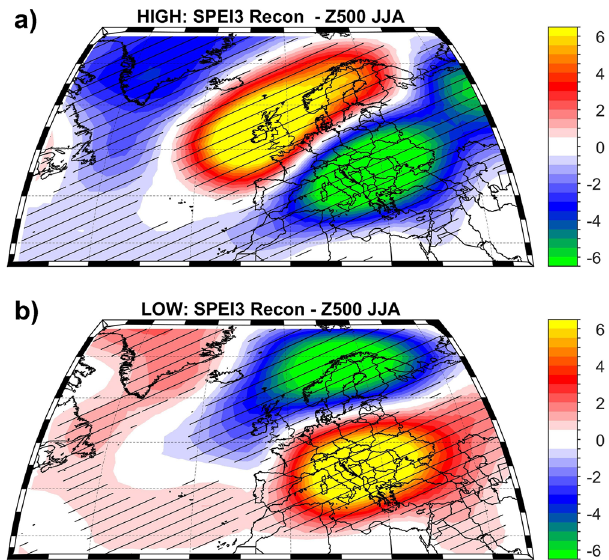
Fig. 5 Large-scale atmospheric circulation. a The composite map between High SPEI3 (< − 1 std. dev.) and summer (JJA) Geopotential Height at 500 mb (Z500) 100 and b the composite map between Low SPEI3 (>1 std. dev.) and summer (JJA) Geopotential Height at 500 mb (Z500). The hatching highlights signi fi cant anomalies at a con fi dence level of 95%. Units: Z500 (m). Analyzed period: 1604 – 2003CE.